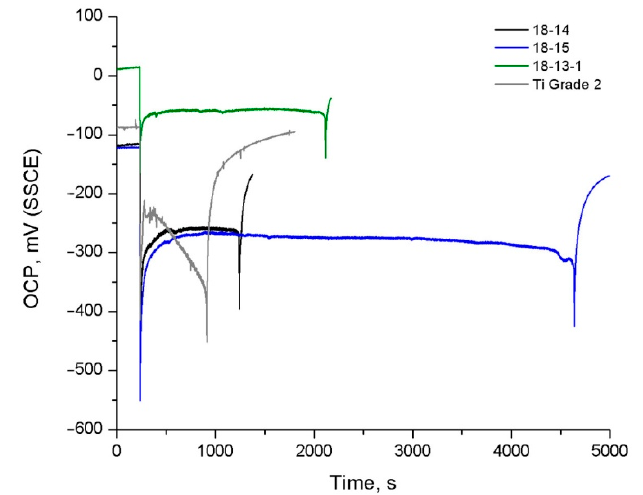
Figure 6. Typical OCP curves of the 18-14, 18-15, and 18-13-1 alloys subjected to TMT and Ti Grade 2 obtained during mechanocycling in Hanks’ solution (1.5% strain, 0.9 Hz). Table 7. Electrochemical parameters and functional fatigue life ( N max ) of the 18-14, 18-15, and 18-13-1 alloys and Ti Grade 2 obtained during mechanocycling in Hanks’